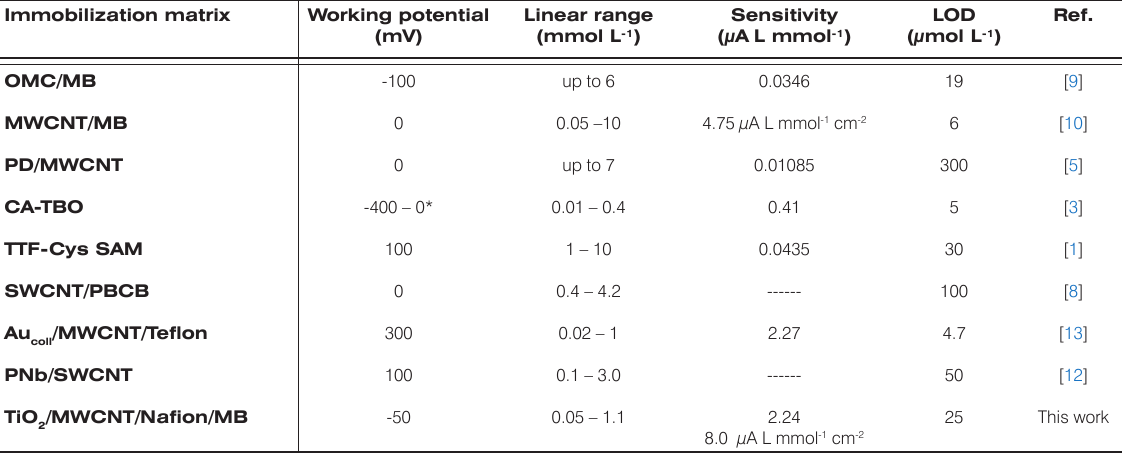
Table 1. Comparison of analytical characteristics of mediator and CNT-based ADH biosensors for ethanol. Immobilization